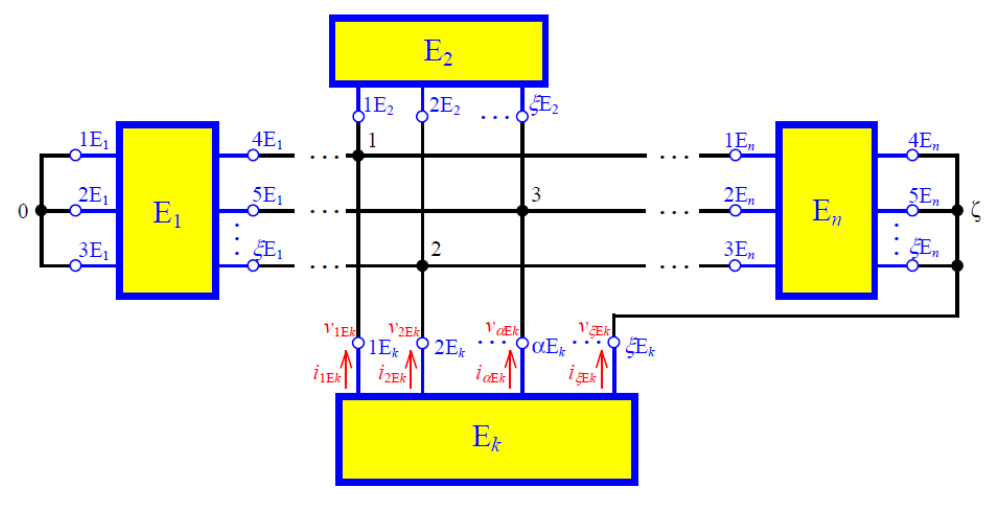
Figure 2. Schematic diagram of a generalized electrical